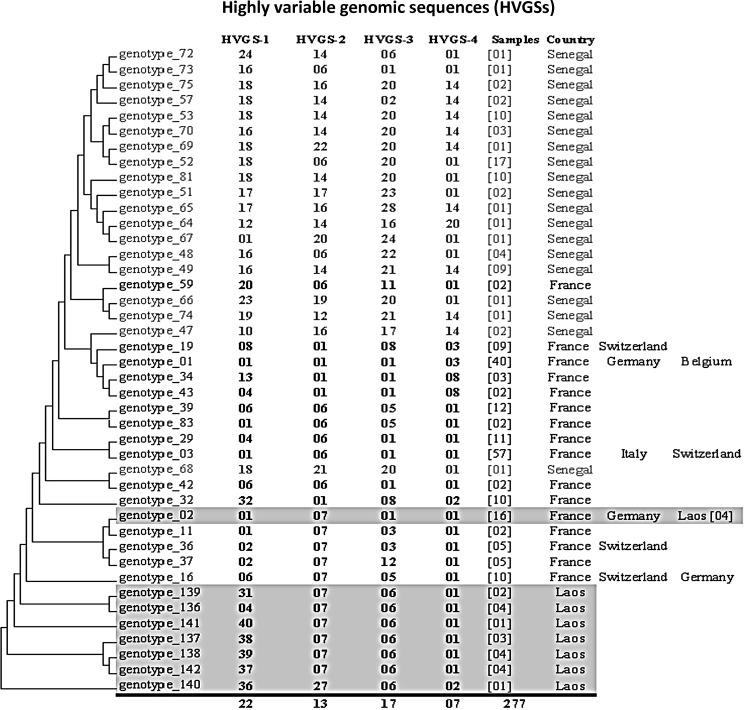
Genetic diversity of 42 genotypes of Tropheryma whipplei obtained from 277 samples.Phylogenetic trees were constructed using the maximum likelihood method based on the Tamura 3-parameter substitution model. The countries in which the genotype has been detected are presented opposite the genotype, and the number of different individuals in which the genotype has been detected is provided in parentheses. The genotypes of each highly variable genomic sequence (HVGS) have intervened in 22, 13, 17 and 7 different combinations, respectively.